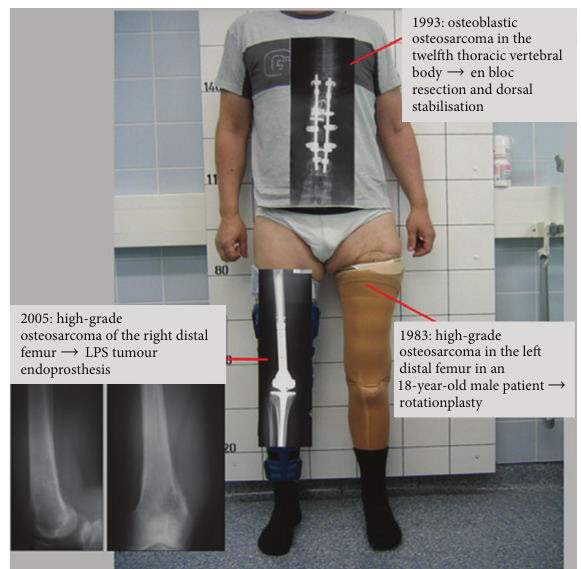
Figure 2: Overview about localisation, timely occurrence, and operative intervention of the three metachronous osteosarcomas as in our 48-year-old male patient 30 years after first osteosarcoma